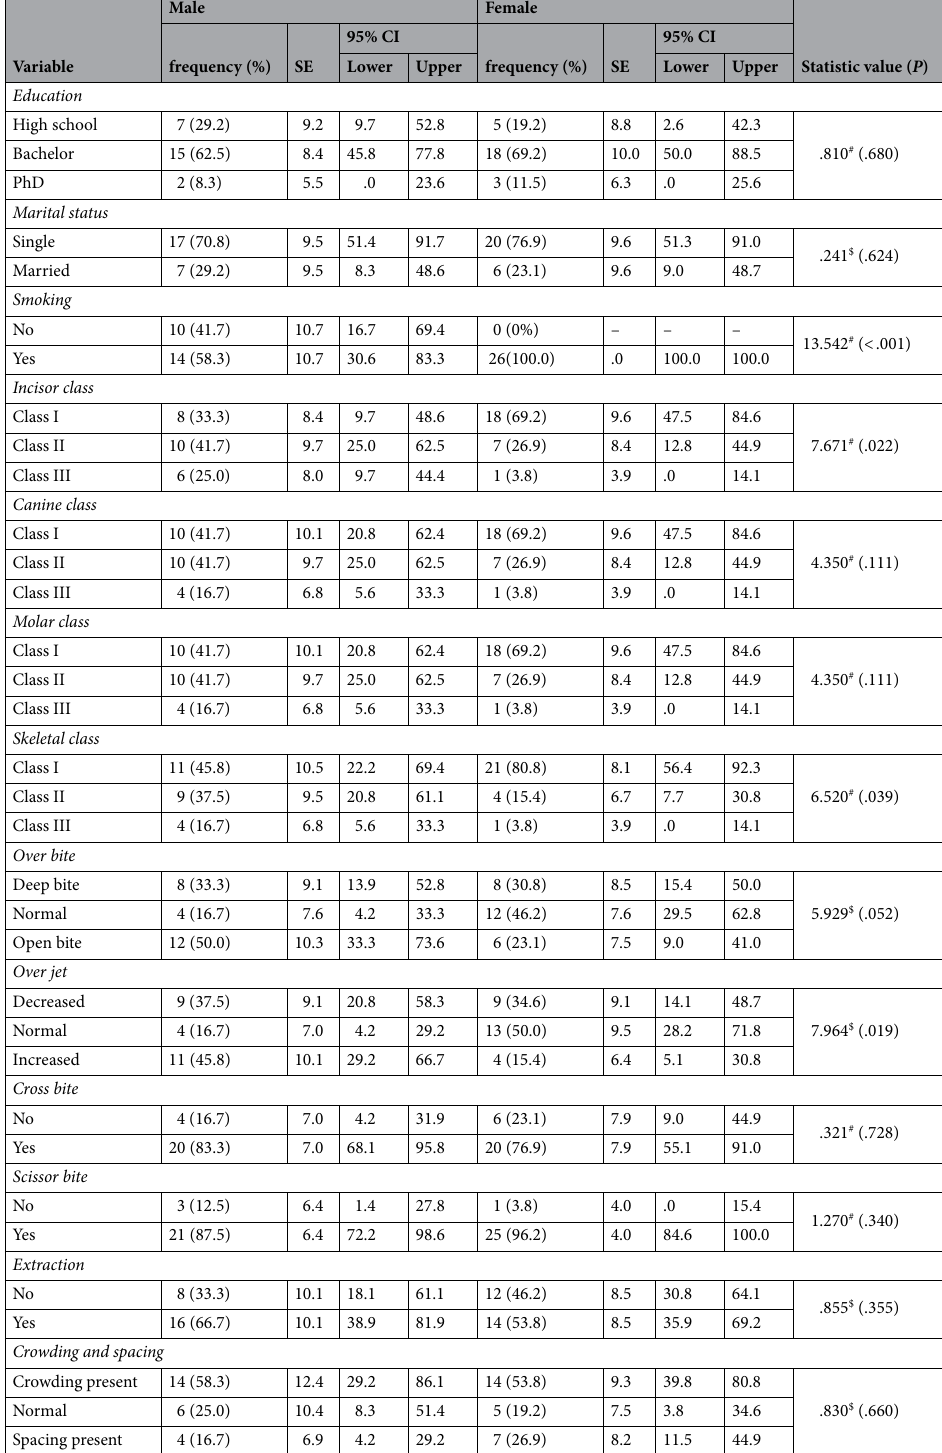
Table 1. Gender differences and distribution of frequencies, percentages, standard errors, and 95% confidence intervals of demographic and dental variables among the study participants (n = 50, 24 males and 26 females). SE = Standard error, CI = 95% confidence intervals of the percent, $ = Calculated via Chi Square test, # = Calculated via Fisher’s Exact